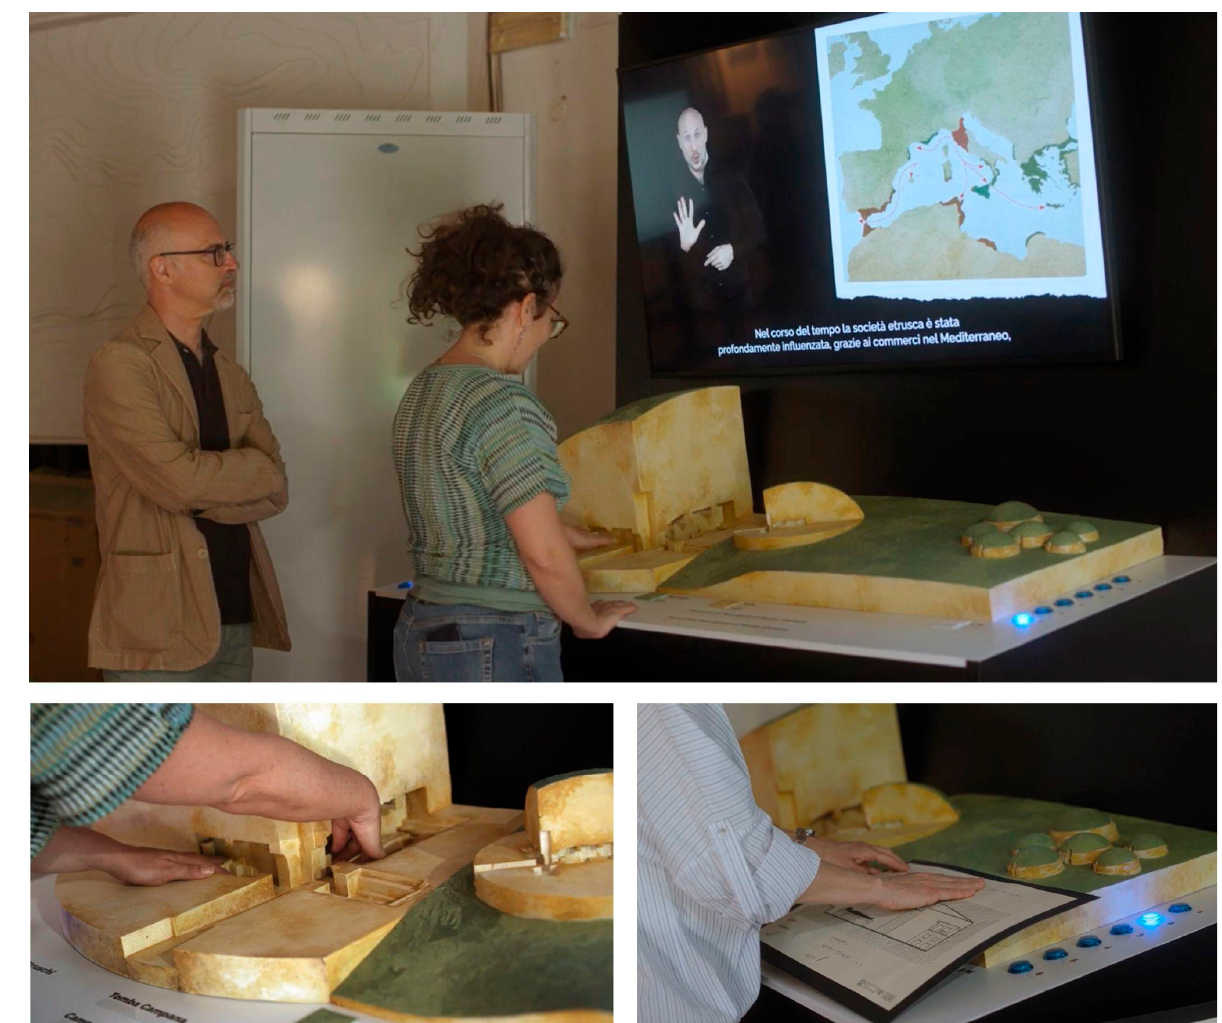
Figure 13. e-Archeo Tactile: some photos of the tangible user interface in Cerveteri (by Collettivo Digitale and accessibility experts).